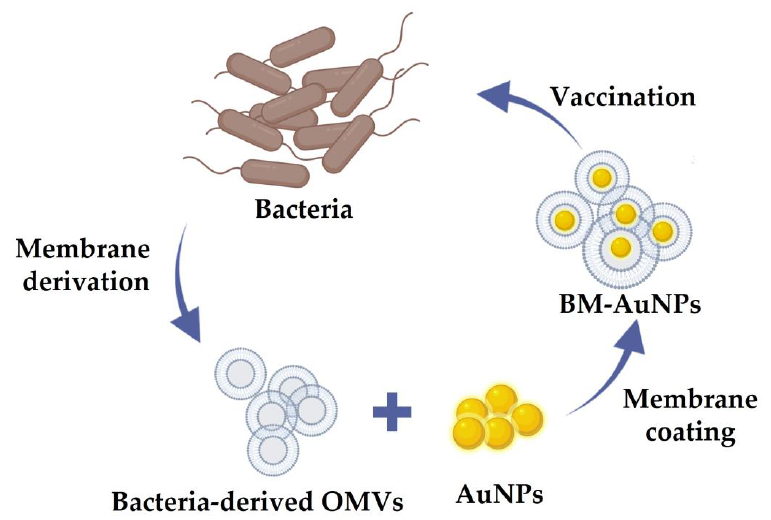
Figure 6. Schematic of the preparation of BM-AuNPs and their application for antibacterial vaccine. Reproduced with permission from Reference [16], copyright American Chemical Society.